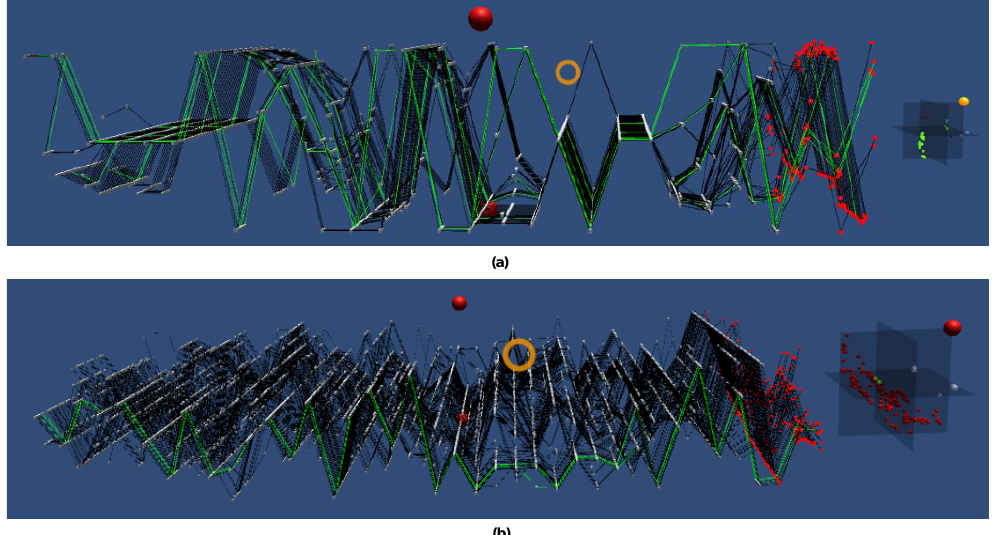
Figure 1. The Immersive Parallel Coordinates Plots (IPCP) of the ( a ) DS1 and ( b ) DS2 datasets respectively with the accompanying 3D scatter plot generated by mapping onto it the three criteria dimensions (selected in red). Both the IPCP and scatter plots selectors are visible (red spheres) as well as the orange cross-hair used for the user’s gaze tracking. The observable difference in the size of the scatter plots is caused by the different perspectives from which the screen-shots were